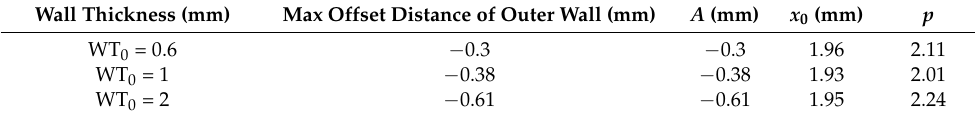
Table 2. Fitted parameters of the logistic regression model for OD 0 = 6mm tubes with different WT 0 . Wall Thickness (mm)